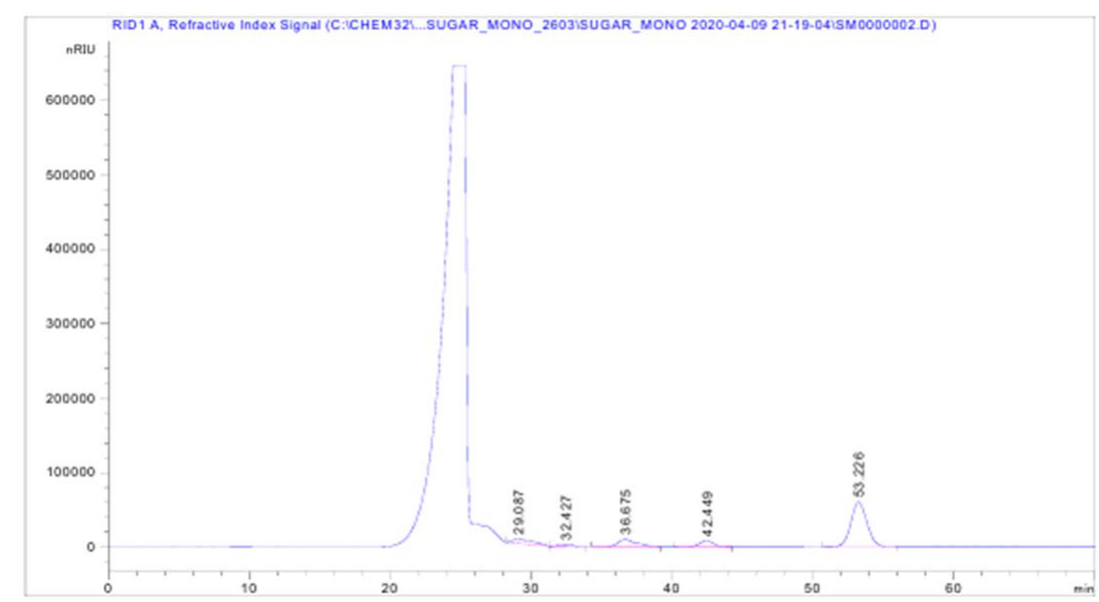
Fig. 3. Chromatogram of PS from Pimpinella anisum